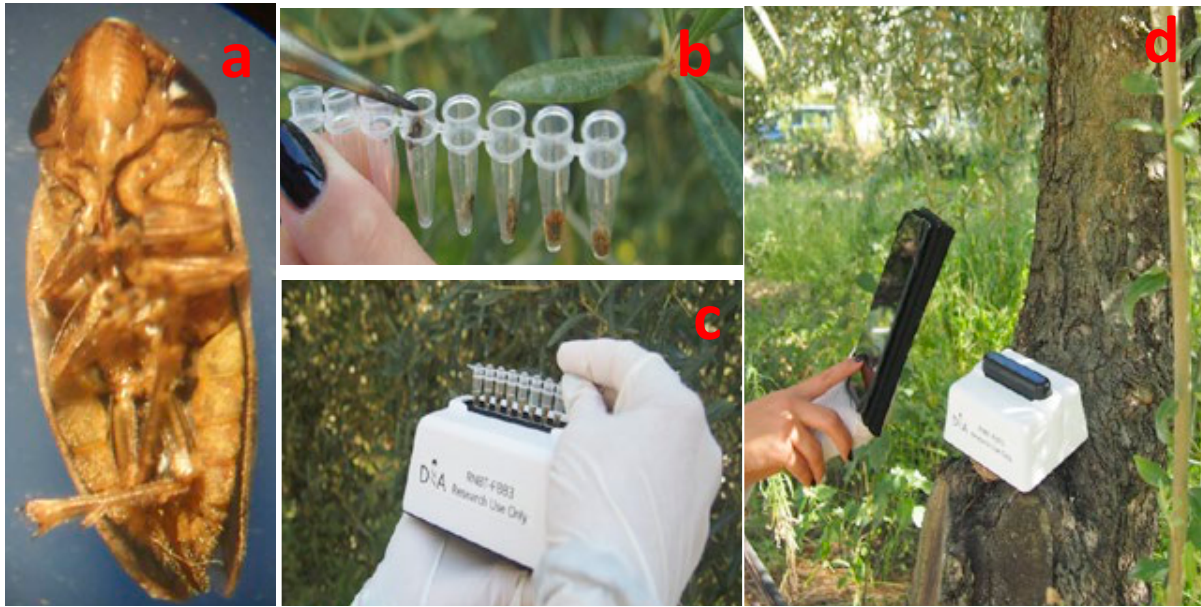
Figure 2. Overview of the on-site detection of X. fastidiosa in ‘spy insects’ using real-time LAMP in SMART DART device directly in the field: a) adult of P. spumarius ; b) collected insects in 0.2 mL extraction buffer; c) DNA extraction; d) real-time LAMP results acquisition by the tablet.